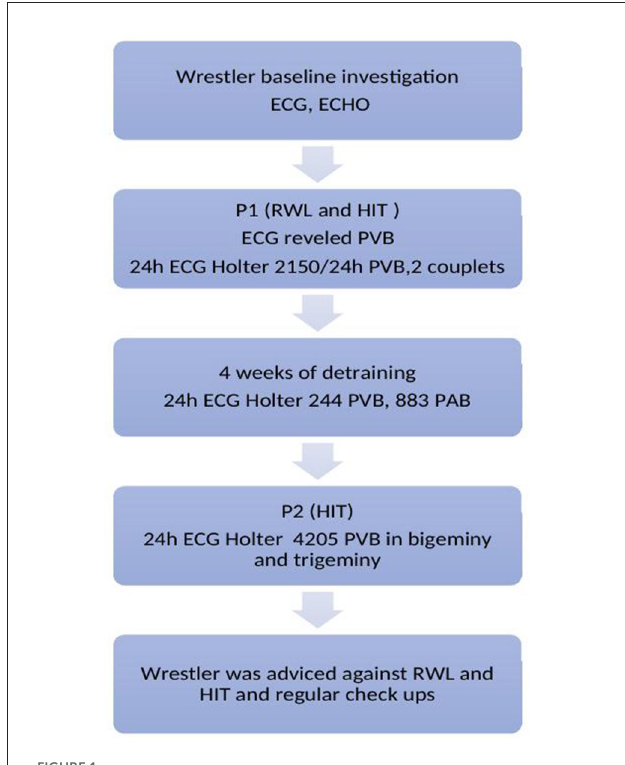
FIGURE1 Timeline legend. ECG, Electrocardiogram; ECHO, Echocardiography; HIT, High intensity training; PVB, Premature ventricular beats; PAB, Premature atrial beats; RWL, Rapid weight